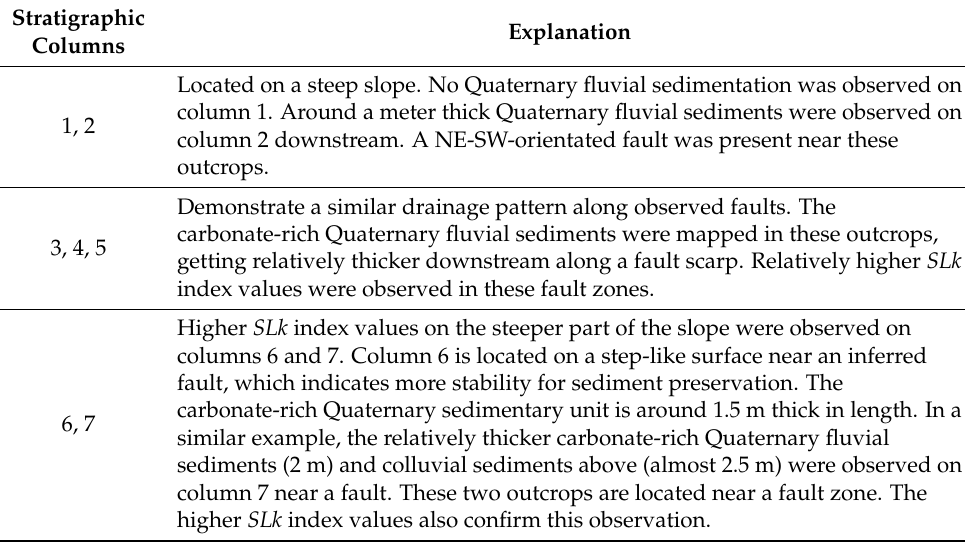
Table 1. Correlated stratigraphic columns with erosion-sedimentation in relation to normal faults explained as given in Appendix A. Also see Figure 11 for the longitudinal profile with SLk